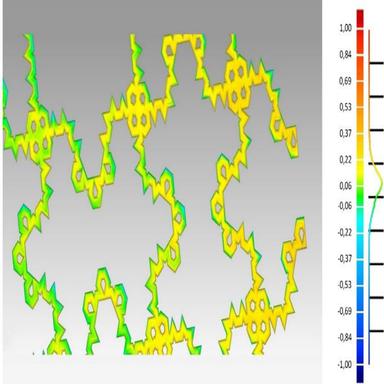
GC test on the Koch mesh KM: ±max = 0,72/−0,54 mm; ±average = 0,11/−0,07 mm; standard deviation = 0,11 mm; RMS estimate = 0,13 mm.